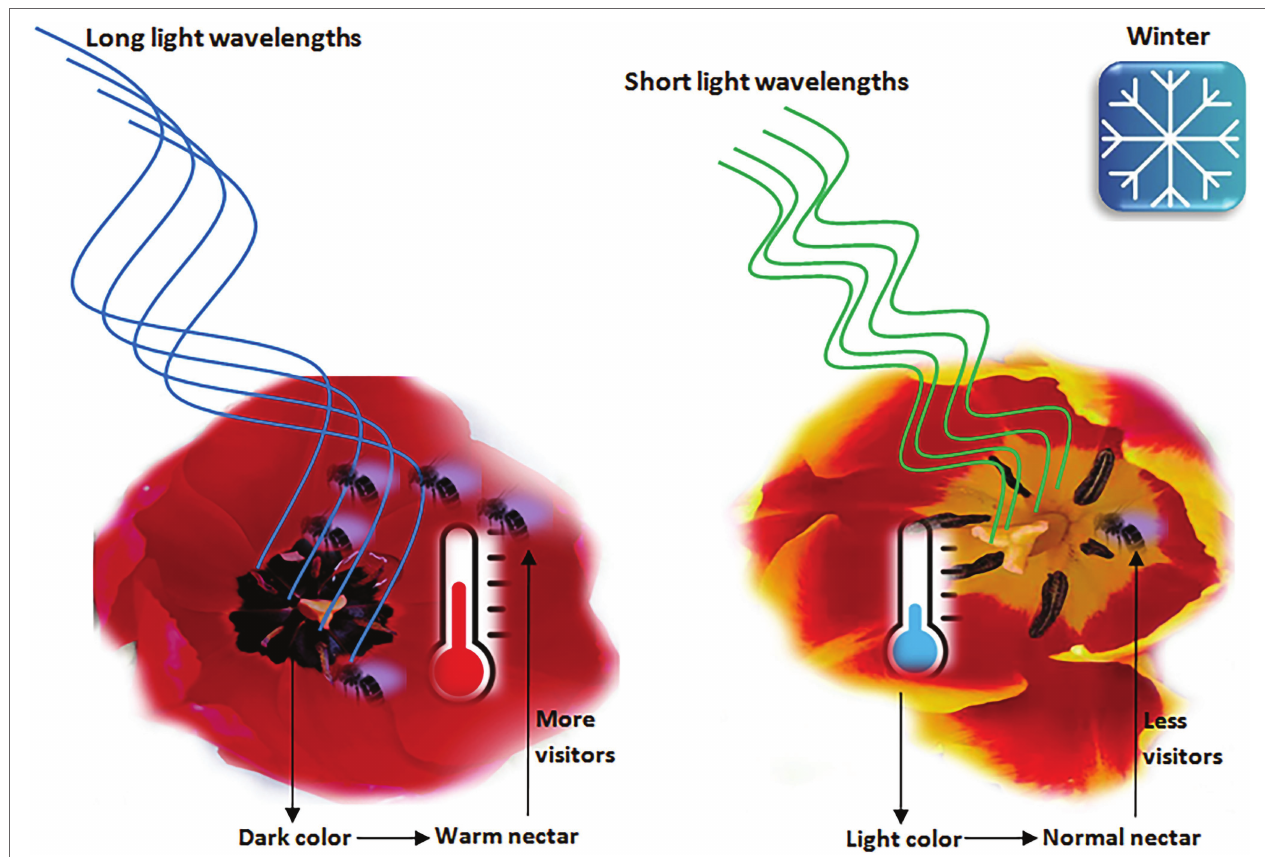
FIGURE 2 | Flower color relationship with heat absorption and pollinators. Dark color flowers absorb sun light with longer wavelengths, which causes increase in the internal temperature of flowers that attract more pollinators in the winter season and allows better pollination. The light color flowers, however, absorb shorter wavelengths of light and do not provide much warm flowers as compared to dark color